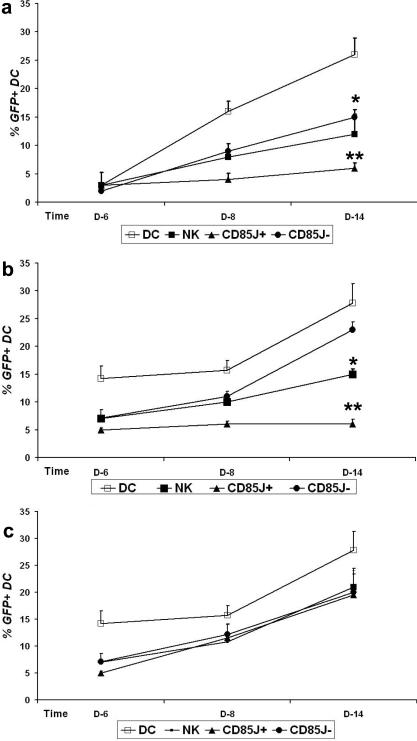
Maintenance of CD85j+ NK cell suppression of HIV-1 replication in DC despite the loss of cytotoxic activity after co-culture with HIV-1-infected DC.(a) NK cells (NK) or the CD85j+ or CD85j− NK cell subsets were added to HIV-1/GFP-infected MDDC 2 hours after infection. (b, c) NK cells or the CD85j+ or CD85j− NK cell subsets derived from 5-day cocultures with HIV-1Bal-infected MDDC (b) or uninfected MDDC (c) were added to HIV-1/GFP-infected MDDC. Kinetics of HIV-1/GFP replication are expressed as percentages of MDDC cells expressing GFP (means+SE) at the indicated time points in eight independent experiments (a) or three independent experiments (b,c) Significant differences between HIV-1/GFP-infected MDDC cultures without NK cells (DC) and MDDC/NK cocultures on day 14 are indicated * p<0.05, **p<0.001.